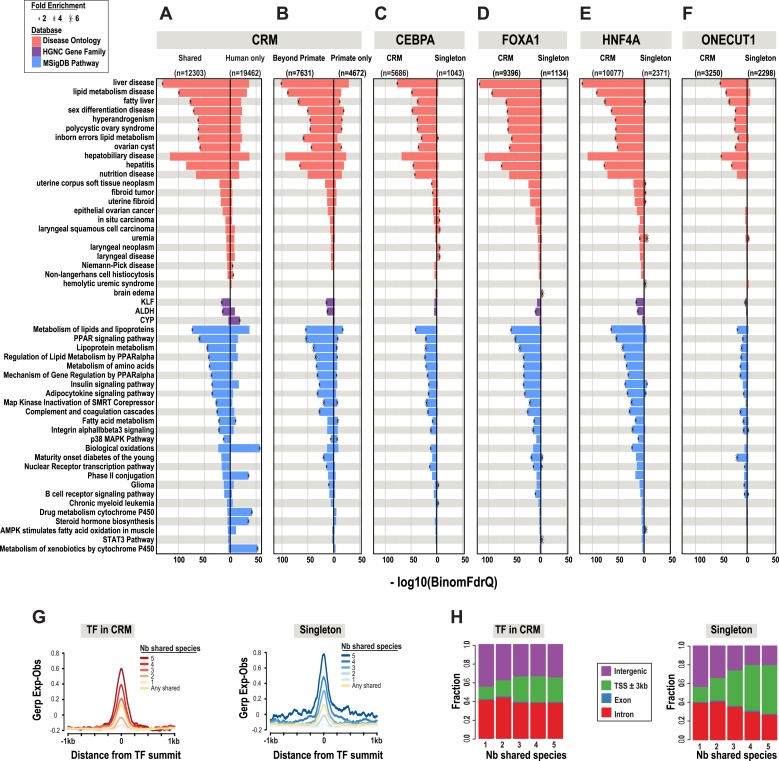
Phylogenetic filtering of experimentally determined liver TF binding events yield distinct functional enrichments.Results were obtained using the programming interface for the online enrichment tool GREAT version 2.02 (McLean et al., 2010) and plotted with custom R scripts. Up to five of the most significant enrichments obtained for each of the six analyses are listed on the left. The −log10 of binomial Q values for Disease ontology, HGNC gene family, and MSigDB are shown along the x-axis. Bars with a black asterisk indicate significant enrichments using GREAT default parameters (binomial and hypergeometric FDR Q-value significance at P ≤ 0.05 with at least twofold region enrichment). The size of the asterisk is proportional to the fold enrichment obtained for the given database. See Figure 3—source data 1 for complete list of Q-values, fold enrichments, genes giving the enrichments along with results from additional databases. (A) Enrichment analysis of any CRM shared in human plus at least one additional species is shown on the left and human only CRMs are shown on the right (Figure 3—source data 1A). (B) Human CRMs (left panel) shared in human and at least one non-primate (Beyond Primates) is shown vs Human CRMs (right panel) shared in human and macaque but no other species (Primate only) (Figure 3—source data 1B). (C) Enrichment analysis of shared CEBPA CRMs and singletons (Figure 3—source data 1C). (D) Enrichment analysis of shared HNF4A CRMs and singletons (Figure 3—source data 1D). (E) Enrichment analysis of shared FOXA1 CRMs and singletons (Figure 3—source data 1E). (F). Enrichment analysis of shared ONECUT1 CRMs and singletons (Figure 3—source data 1F). (G) Human TFs in CRMs and Singletons were categorized by the number of species in which they are shared with. Profiles of constrained elements (sequence conservation) in a 1-kb window around CRMs or singletons were calculated using GERP scores from the 29-way multiple sequence alignments. (H) Genomic location of CRMs and Singletons. Proportion of single TFs located near transcription start sites (TSS) increases to >50%, but remains stable for CRMs at ∼20%.DOI:
http://dx.doi.org/10.7554/eLife.02626.01010.7554/eLife.02626.011Figure 3—source data 1.Functional enrichment results obtained for CRMs and singletons using GREAT.